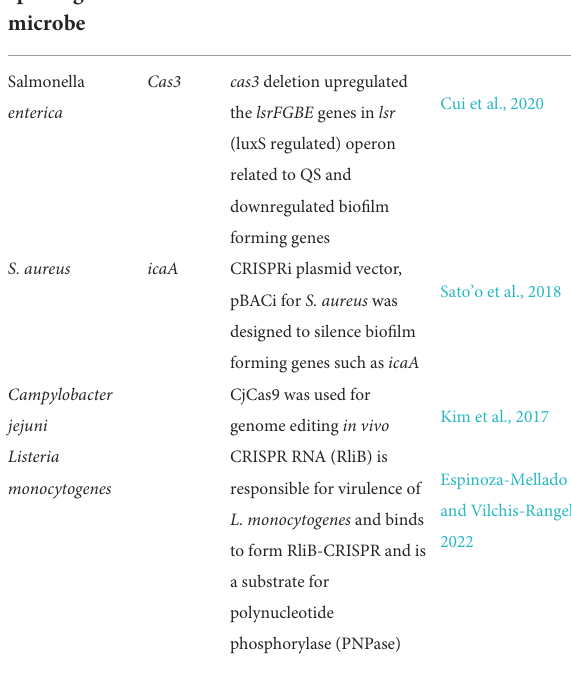
TABLE 2 Genes studied from food spoilage organisms responsible for food degradation.